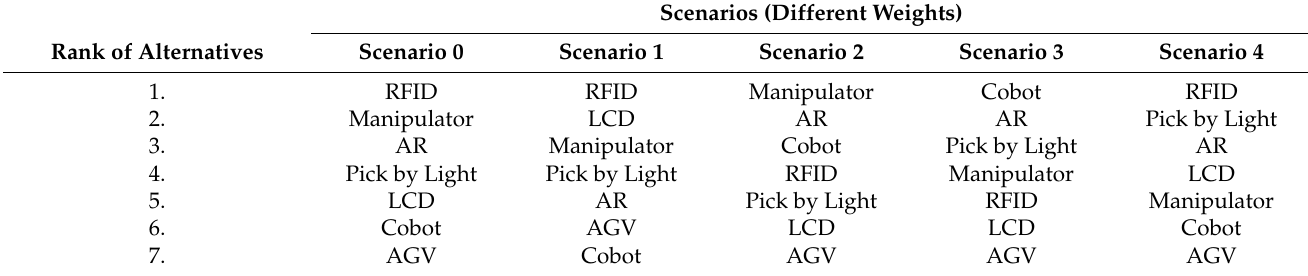
Table 2. The rank of alternatives for each observed